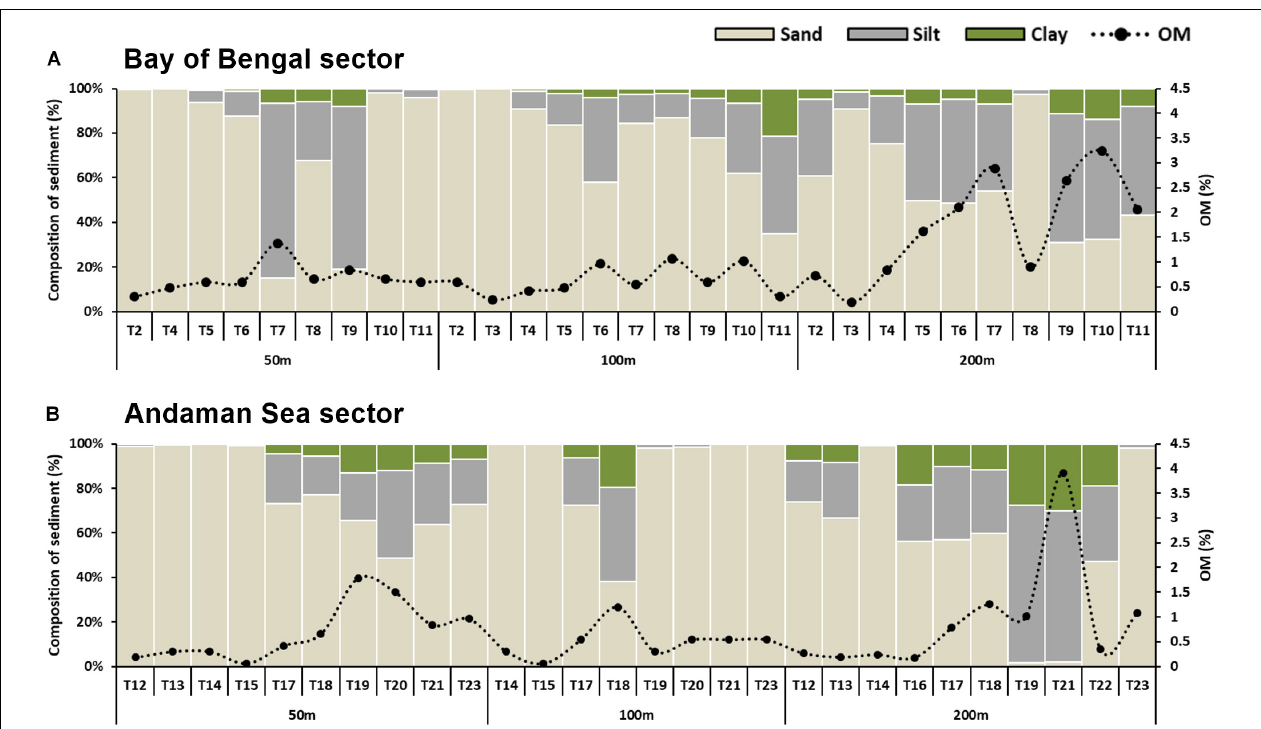
FIGURE 3 | Percentage composition of sand, silt, clay at 50, 100, and 200 m depth strata along (A) Bay of Bengal sector (BoB), and (B) Andaman Sea sector (AS). Black ( • ) represents the organic matter content (OM%) at each site.